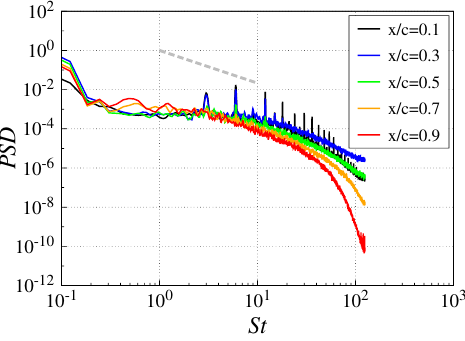
Figure 22. Power spectrum densities (PSDs) of the chordwise velocity fluctuation at the point of the maximum TKE directly above each code length in the Burst case at α =